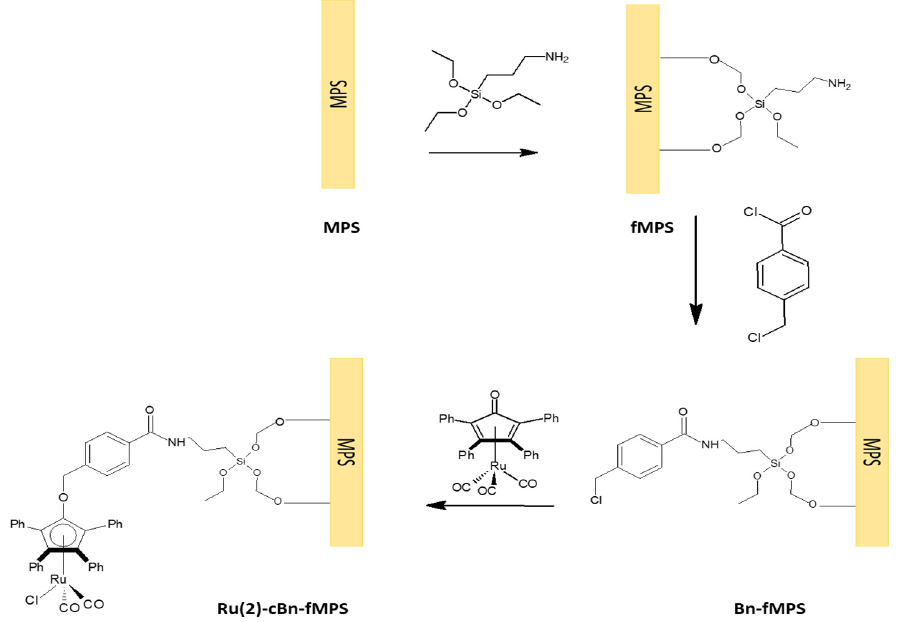
cBn-fMPS (MPS=MCF or SBA).